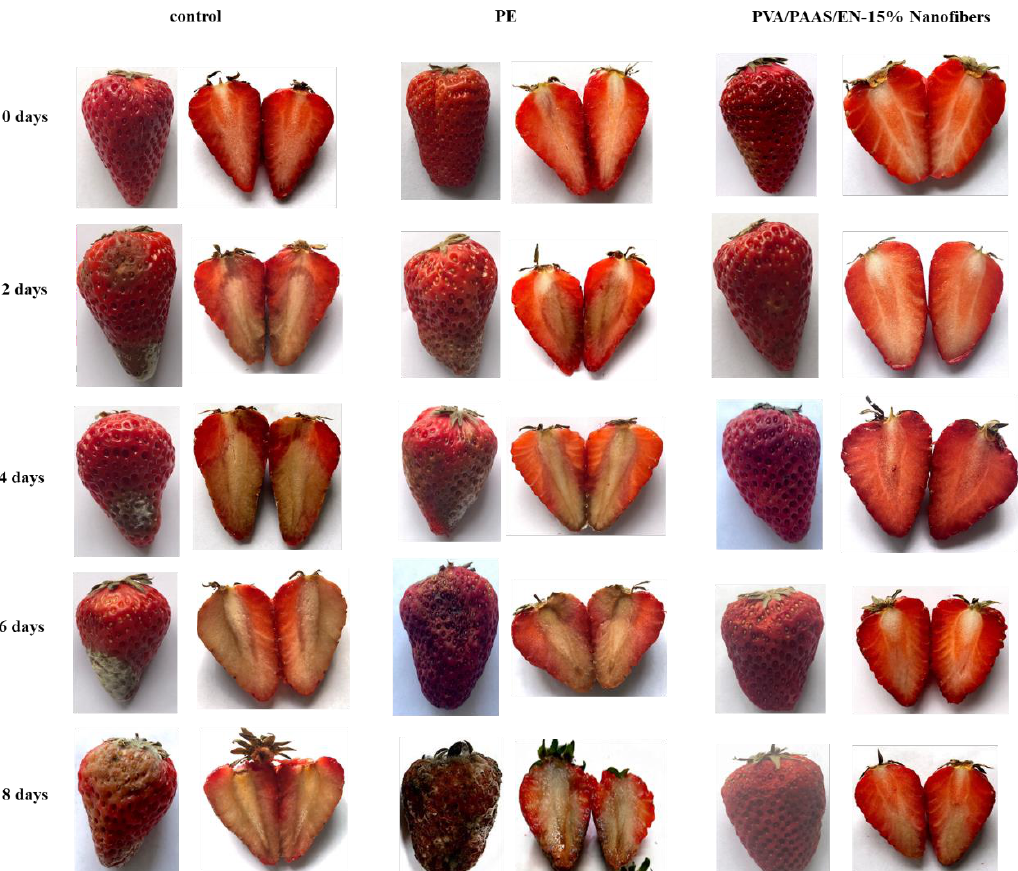
Figure 8. Digital images of the appearance and inner changes of strawberries during storage times.